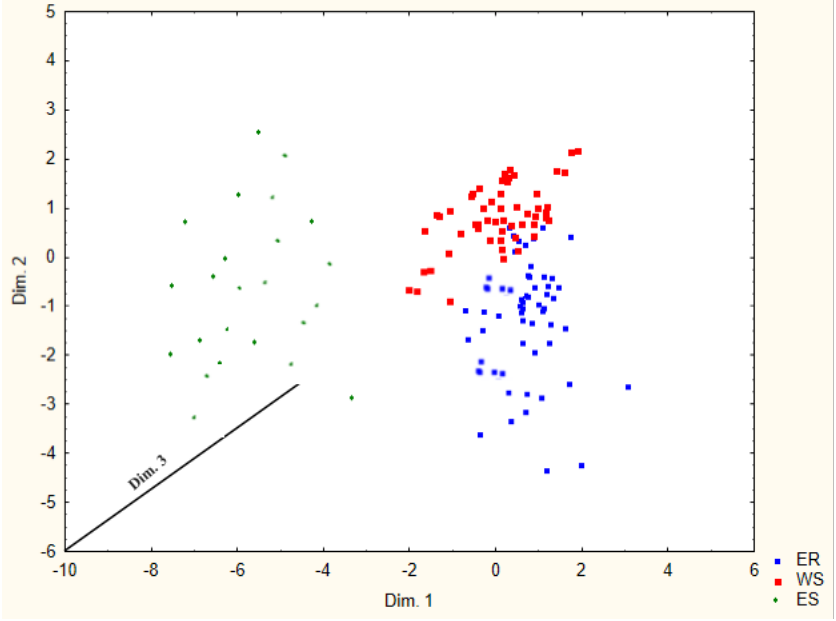
Figure 2. K-means clustering for the most representative parameters: pH, conductivity, color, elements of alkali and alkaline earth metals, from the group of heavy metals and scattered elements.